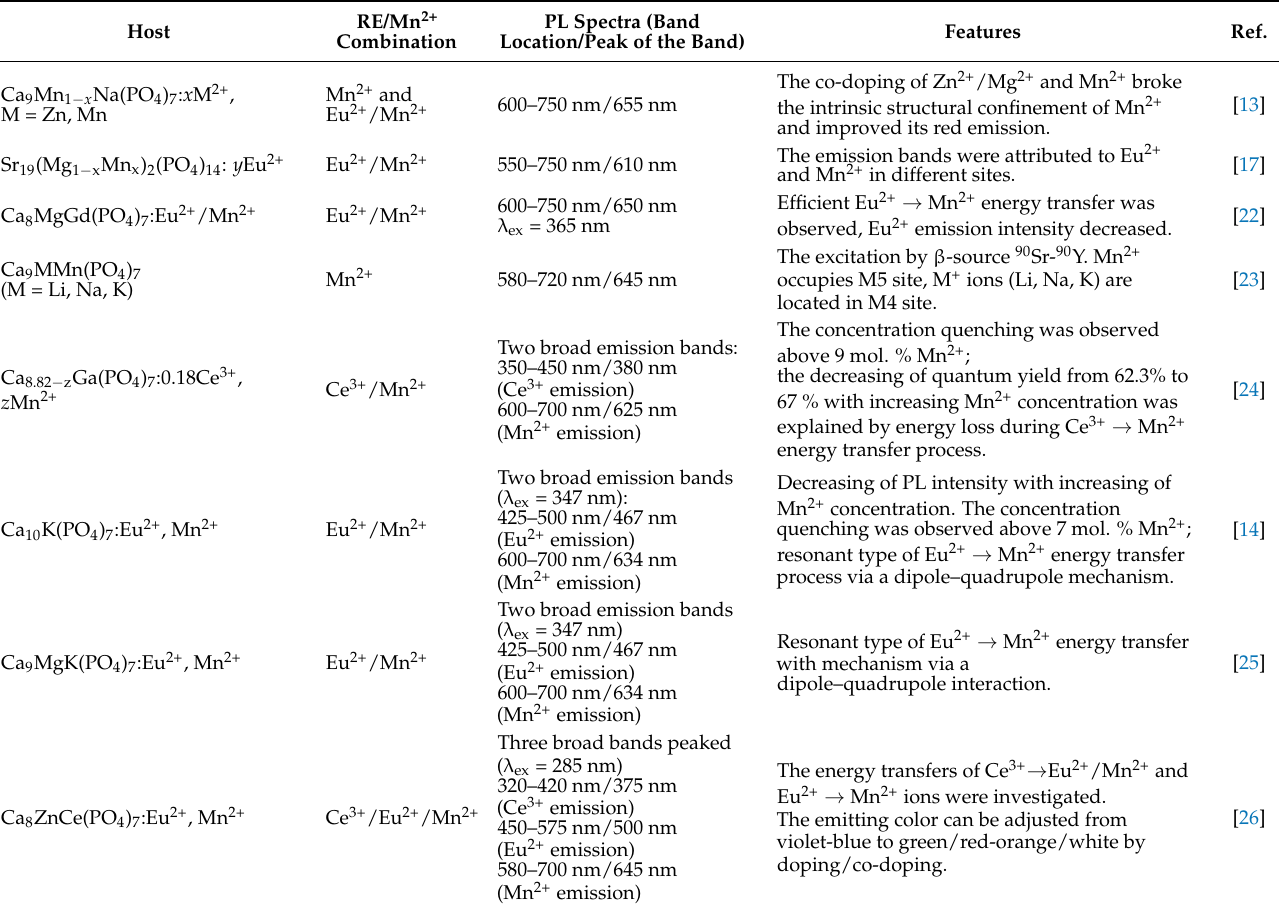
Table 1. The characteristics of PL spectra and some features of Mn 2+ or RE/Mn 2+ -doped β